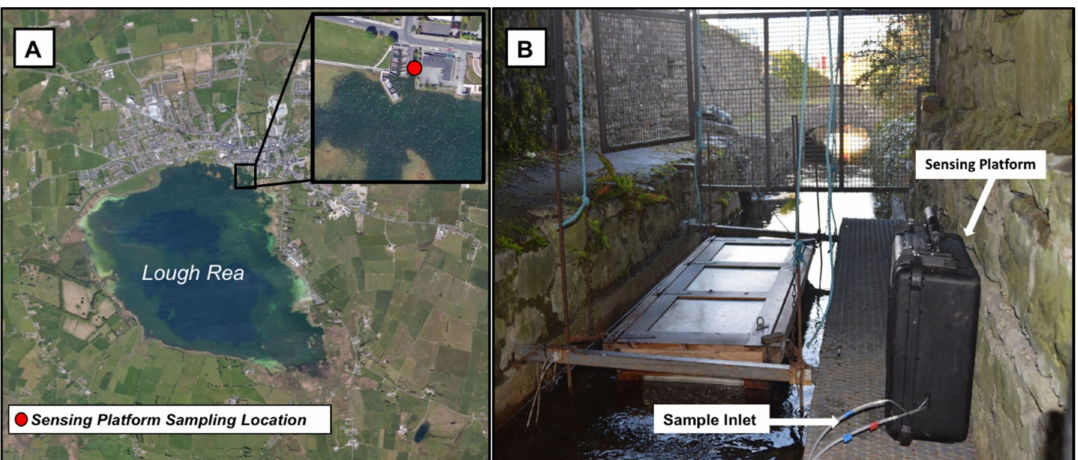
Figure 4. ( A ) Satellite image of the sampling location at Loughrea Co., Galway, Ireland. (53 ◦ 11 (cid:48) 47.5 (cid:48)(cid:48) N: 8 ◦ 34 (cid:48) 6.8 (cid:48)(cid:48) W) [19]. ( B ) Picture of the prototype sensing platform deployment at Lough Rea angler’s fish hatchery, Loughrea Co., Galway, Ireland.